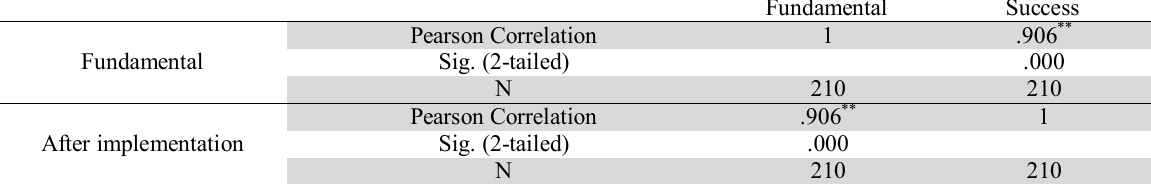
The summary of implementation of Pearson correlation ratio for testing the third hypothesis Fundamental Success Pearson Correlation 1 Fundamental Pearson Correlation After implementation